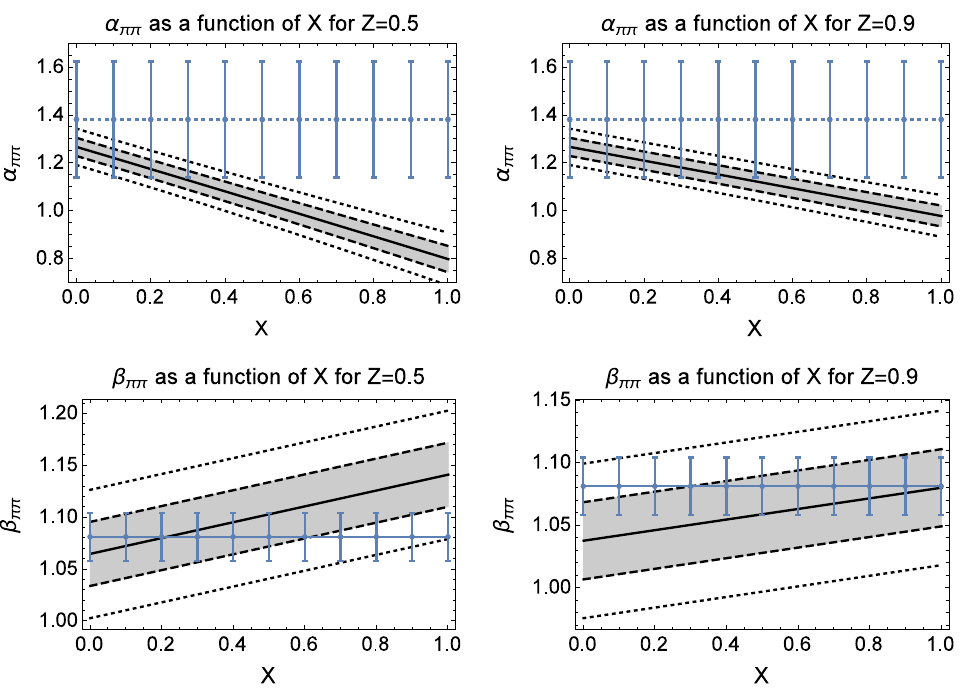
Fig. 1 Subthreshold parameters α ππ and β ππ as a function of X for Z = 0 . 5 and 0 . 9. The median (solid line), the one-sigma band (dashed, shadowed) and the two-sigma band (dotted) are depicted along with the experimental value [7] (solid horizontal line with error